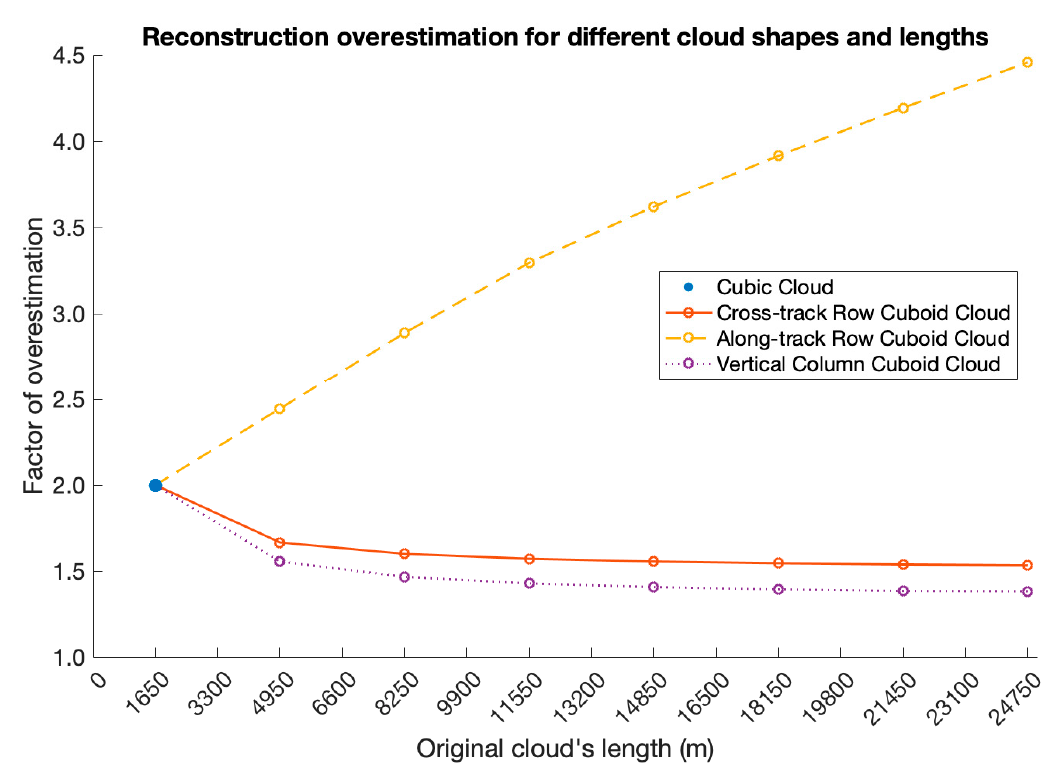
Figure 3. Results from different inputs of cloud shape and length. Here, the length is defined as the